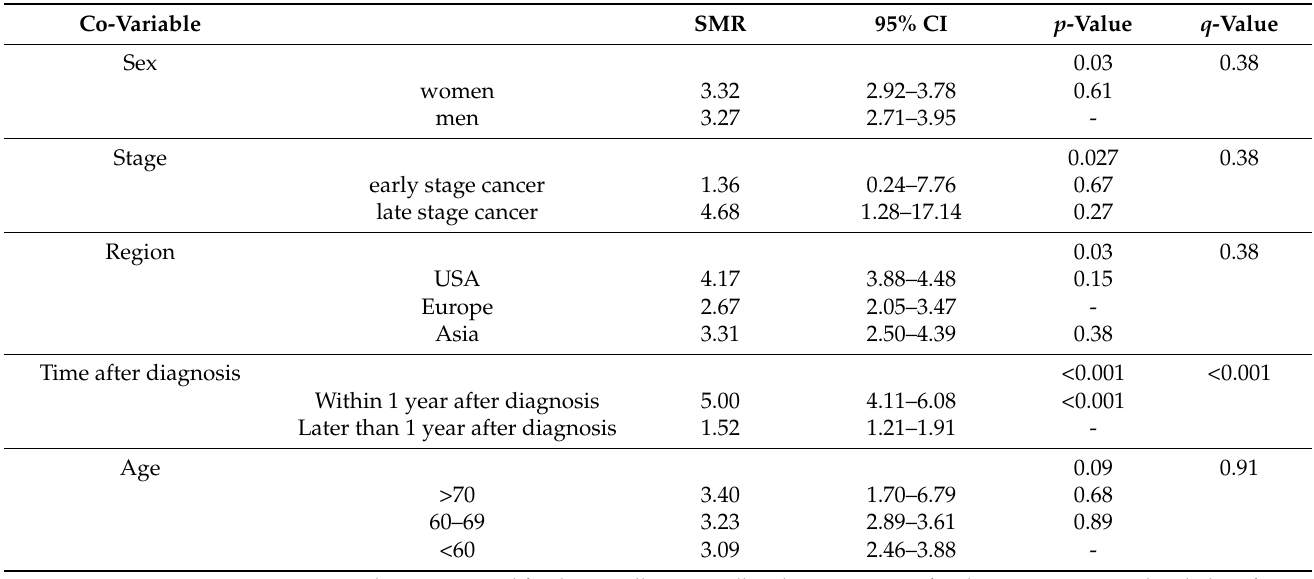
Table A1. Summary table of meta-regression